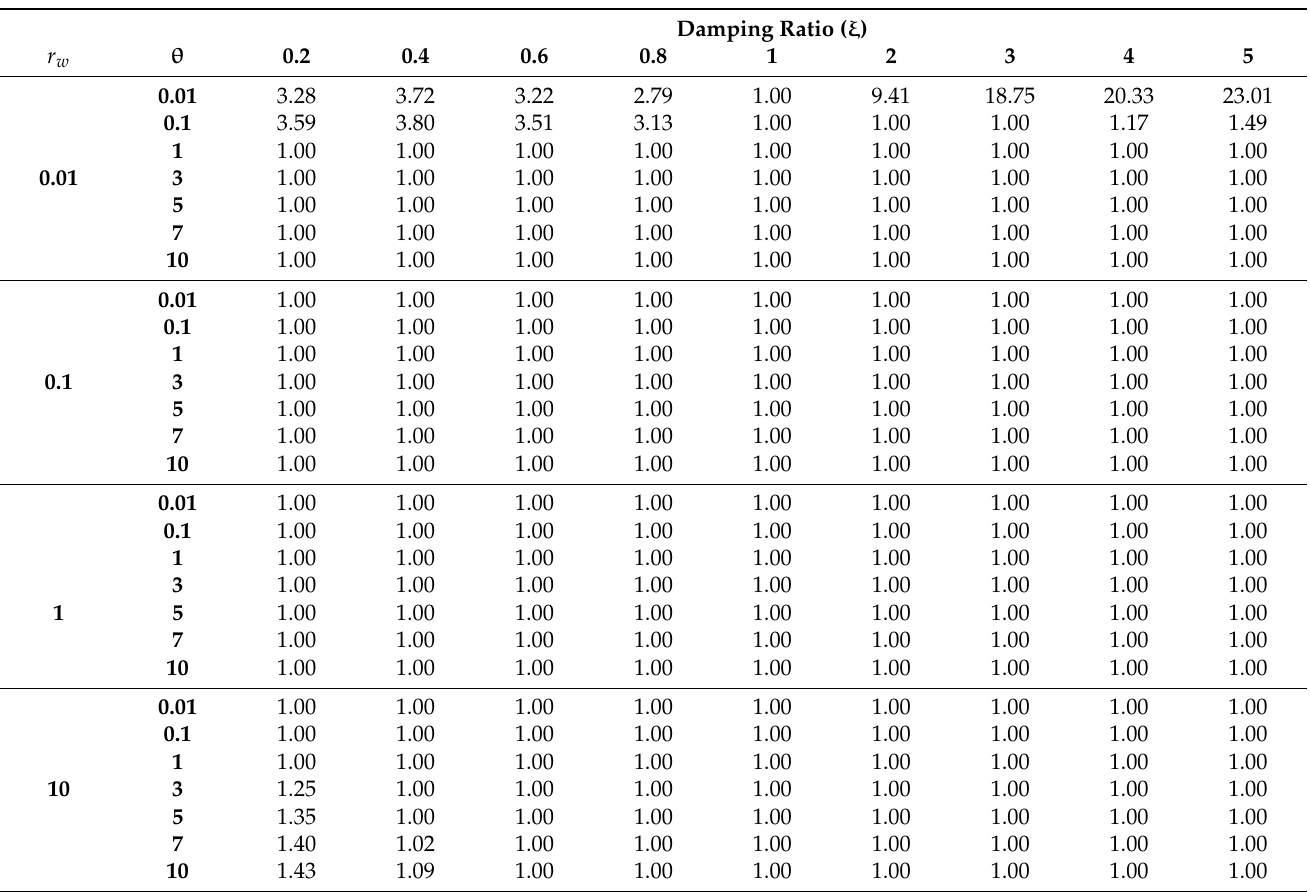
Table 11. Normalized TV for MPC (Process 3, Disturbance